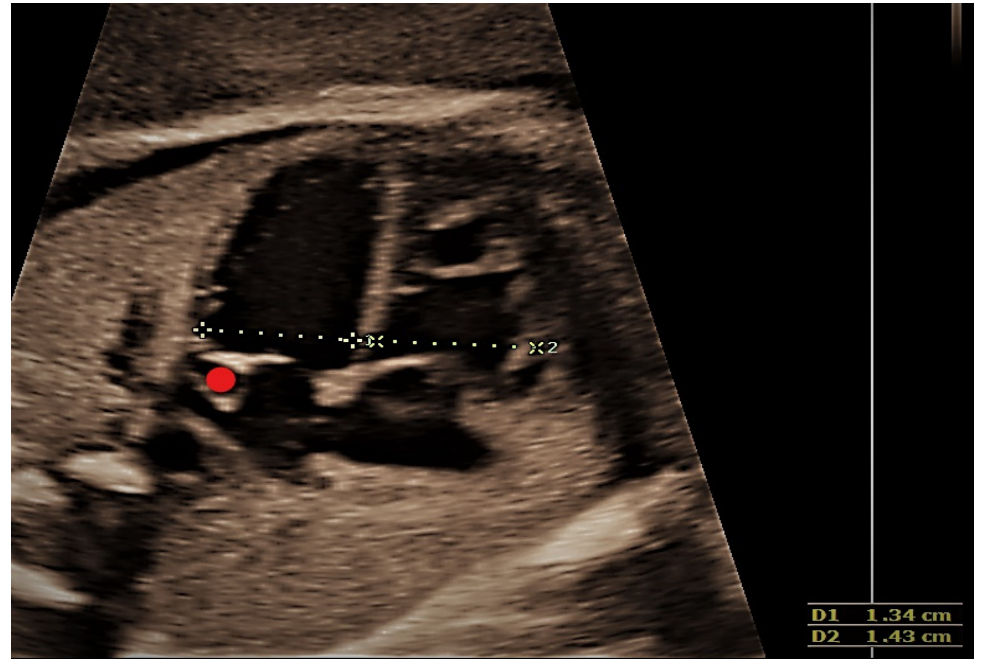
Figure 2. Transversal section of the thorax at 4CV; the red dot marks the dilated coronary sinus in the left atrial wall.